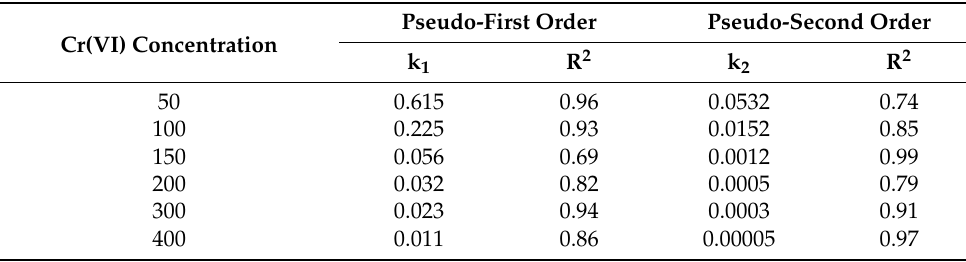
Table 2. First and second order kinetic of Cr(VI) reduction by bacterial consortia and their correla- tion